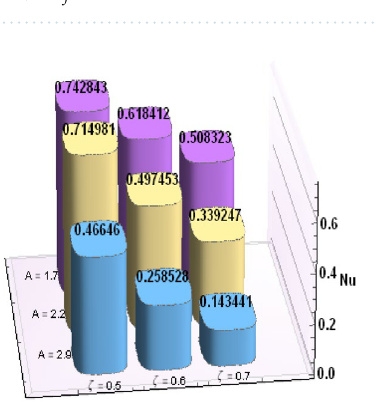
Figure 15. Bar chart representation of Skin friction coefficient and Nusselt number for different parameters using Mathematica 10 software available at (https:// softa sm. com/ wolfr am- mathe matica- 10-4- full- crack/). Re1 /2 r C f versus A.